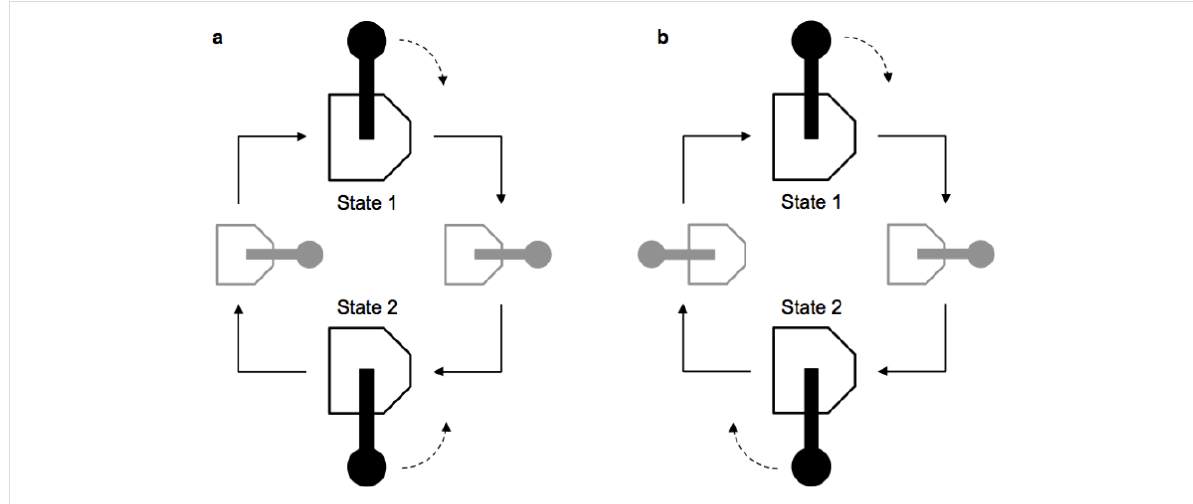
Figure 2: In a switch (a) the interconversion between states 1 and 2 takes place through the same transformation performed in opposite directions. In a motor (b) the conversion from 1 to 2 and from 2 to 1 occurs by following different